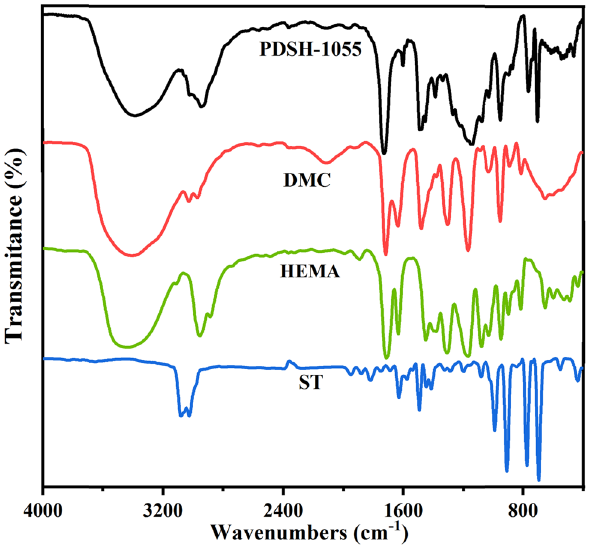
Figure 1: FTIR spectra of PDSH - 1055, DMC, HEMA, and